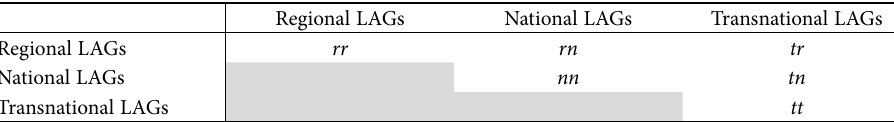
Table 2. Classification of nodes and their relations in a TNC project. Regional LAGs National LAGs Transnational